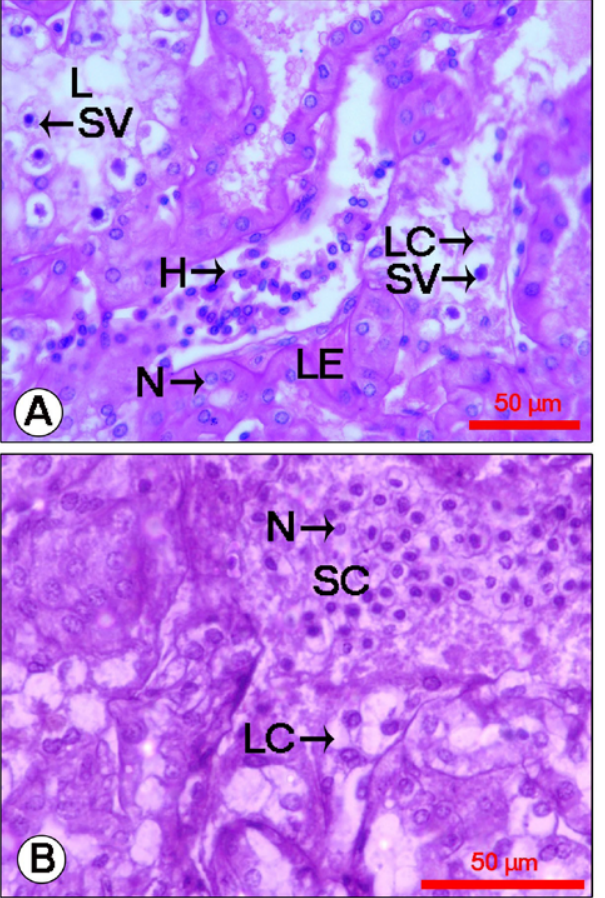
Figure 9. Light micrograph of Y-organ of crabs treated with MF during C4 stage in Travancoriana schirnerae. ( A ) Y-organ demonstrating abundance of hemocytes and secretory vesicles. ( B ) Proliferated smaller cells seen in small patches. H: Hemocyte; L: Lobule; LC: Larger cell; LE: Lobular epithelium; N: Nucleus; SC: Smaller cell; SV: Secretory vesicle.